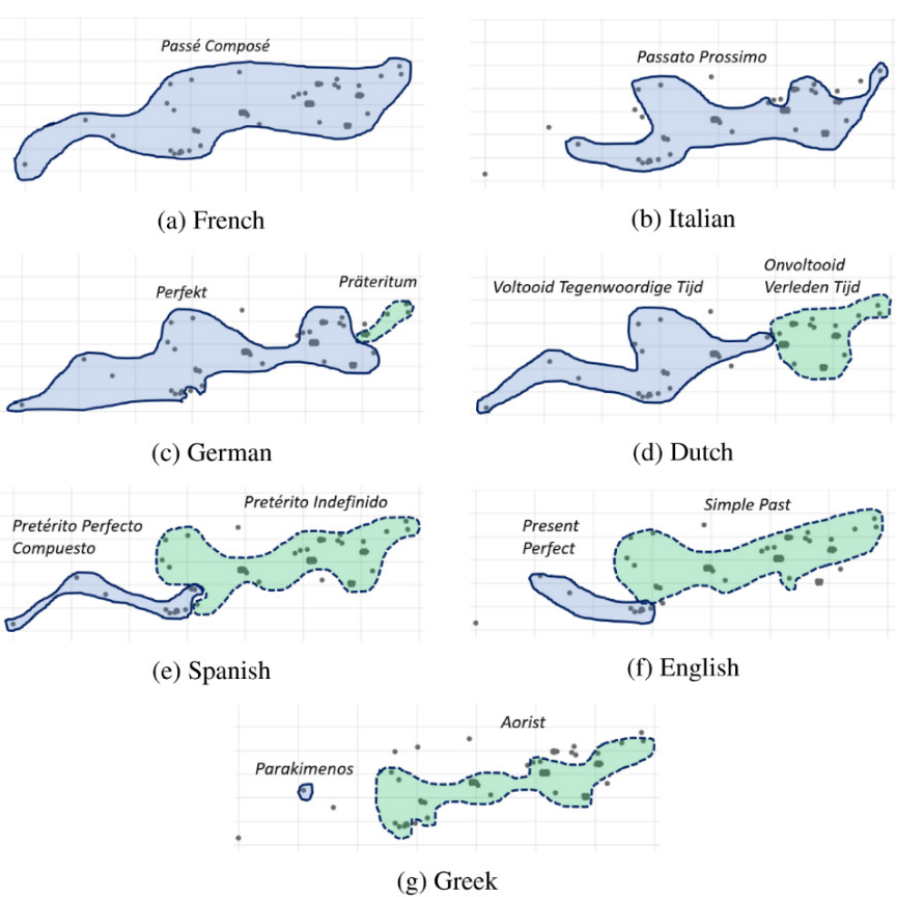
Figure 5. MDS representations of the use of the HAVE -perfect in the different languages included in the corpus of van der Klis et al. (2021a) (see Figure 3 in van der Klis et al. (2021a)). The gray dots in Figure 5a–g stand for contexts from the corpus. The dots are orga- nized in the same way in the different figures, and their organization is based on the first two MDS dimensions. The markup is language-specific and reflects the tense use in the contexts. The blue shapes (full lines) cover contexts with a HAVE -perfect, and the green shapes (dotted lines) contexts with other (past) tenses ( Präteritum , Onvoltooid Verleden Tijd ,